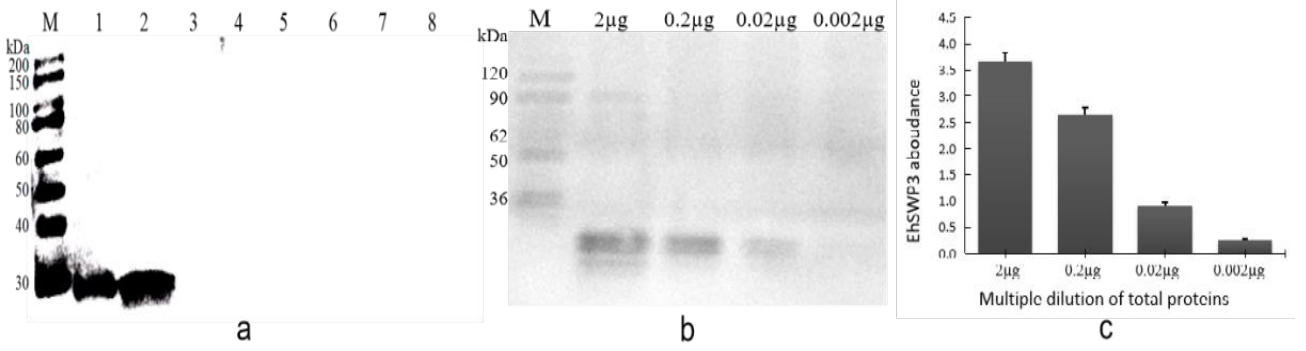
Figure 9. Immunoelectron microscopy localization of EhSWP3 on the spore wall of purified Enterocytozoon hepatopenaei spores. The sections were immuno-labeled with PAbs anti-EhSWP3 followed by GAR-IgG conjugated to gold (10 nm probe). ( a1 , a2 ) Electron micrographs of EhSWP3 in E. hepatopenaei spores. The presence of EhSWP3 was marked with white arrows. ( b ) The control was probed with normal rabbit serum. Abbreviations: Ex: exospore layer; En: endospore layer; Cp: cytoplasm; PT: polar tube.